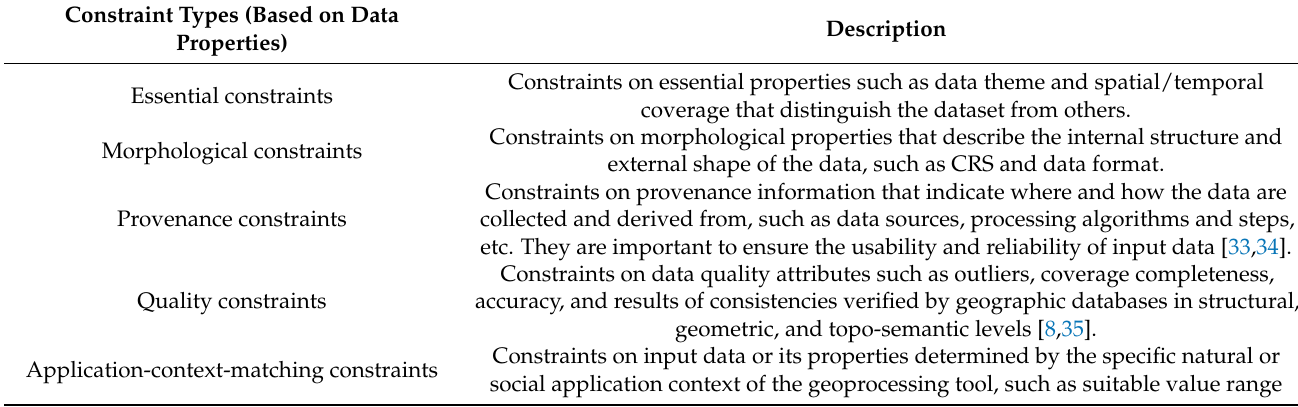
Table 3. Classification of parameter constraints according to the constrained types of data properties. Constraint Types (Based on